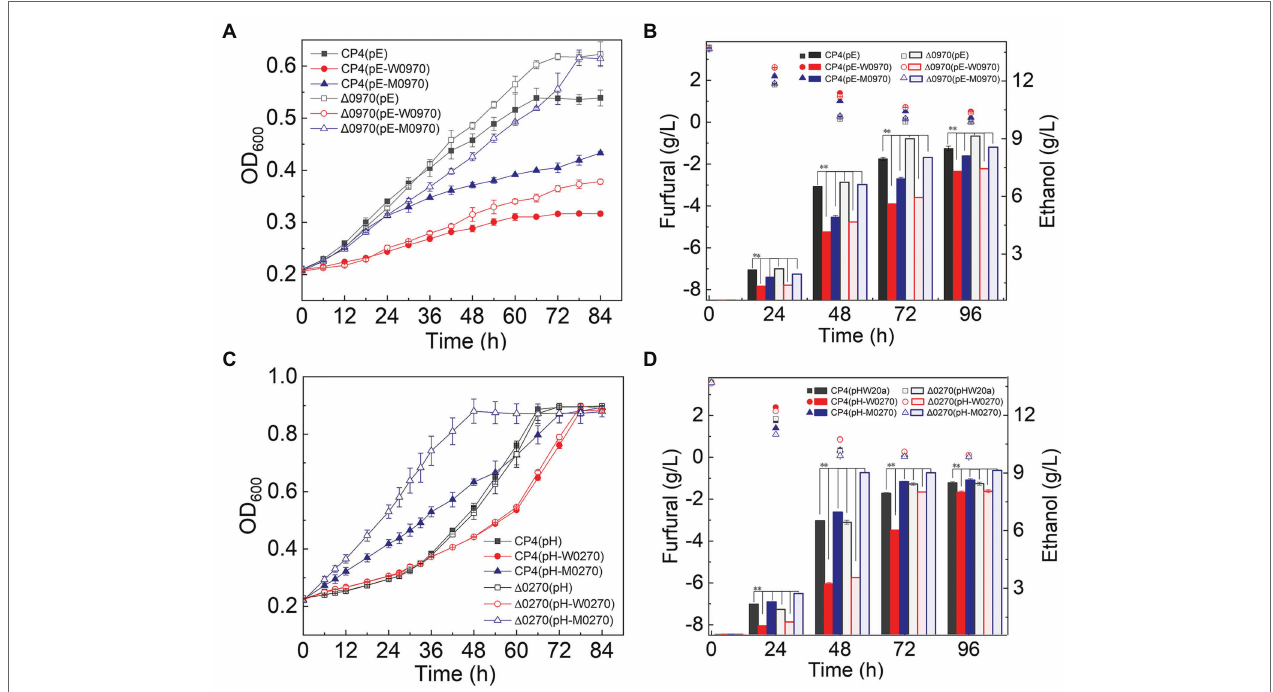
FIGURE 1 | Growth and fermentation of the functionally complementary strains of genes ZCP4_0270 and ZCP4_0970. Panel (A) and (C) indicated that the growth curves of engineered strains of ZCP4_0970 and ZCP4_0270 genes, respectively. The furfural (scatter plot) and ethanol (bar) concentration in RM medium of engineered strains of ZCP4_0970 and ZCP4_0270 genes were shown in Panel (B) and (D) ,